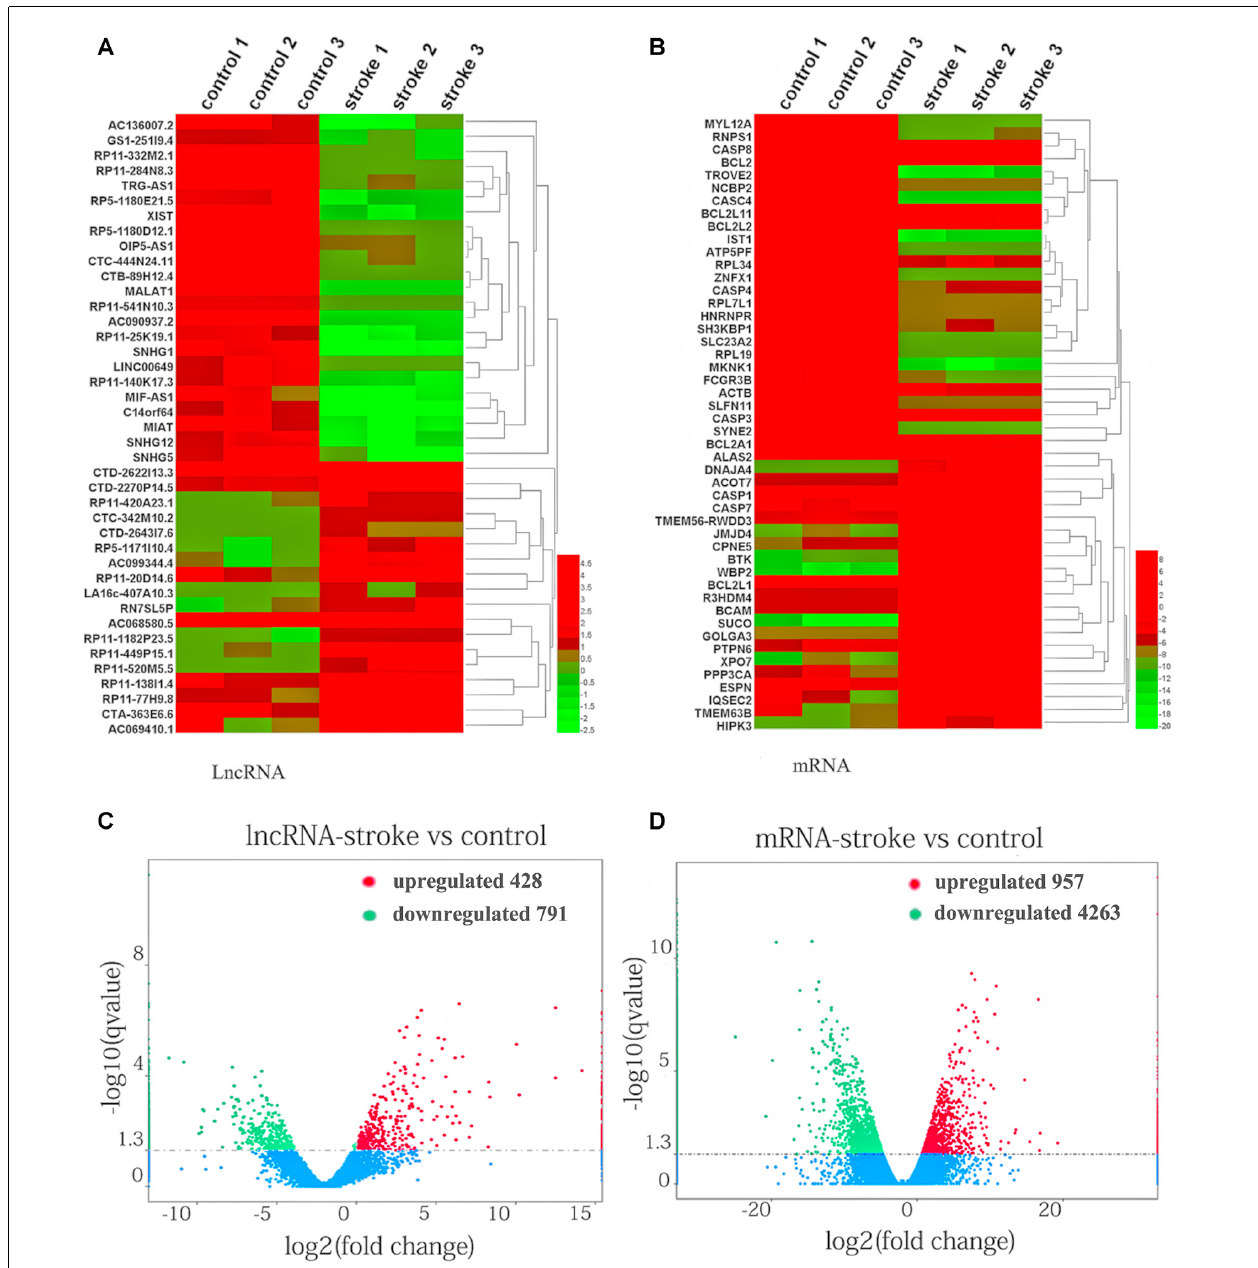
FIGURE 1 | Aberrantly expressed lncRNAs and mRNAs in patients with acute ischemic stroke (AIS) and healthy controls. Heatmap showing the hierarchical clustering of differentially expressed lncRNAs (A) and mRNAs (B) in AIS patients and healthy controls. Up- and downregulated lncRNAs and mRNAs are represented in red and green, respectively. The volcano plot of lncRNA (C) and mRNA (D) expression signals in AIS patients and healthy controls. Red circles represent upregulated genes, green circles represent downregulated genes, and the dotted line in the volcano plot represents the default significant fold